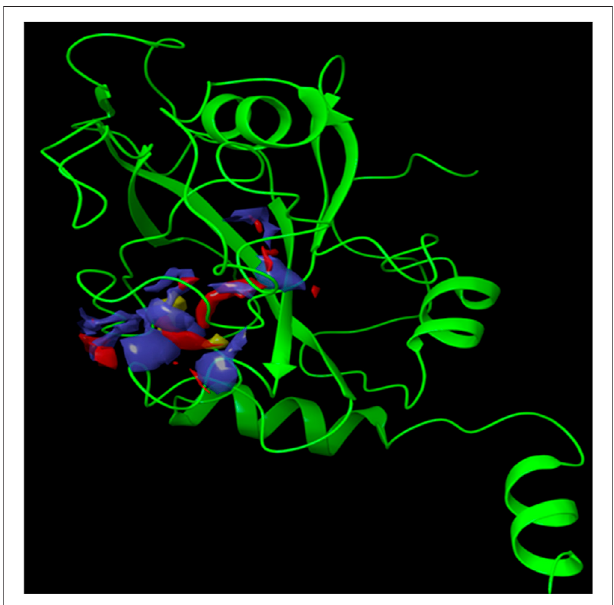
FIGURE 1 | The crystal structure of the SRA domain of E3 ubiquitin- protein ligase UHRF1. SiteMap surface “ red, blue and yellow colour ” of the SRAdomain of E3 ubiquitin-protein ligase UHRF1(PDB: 3BI7) “ Green colour".